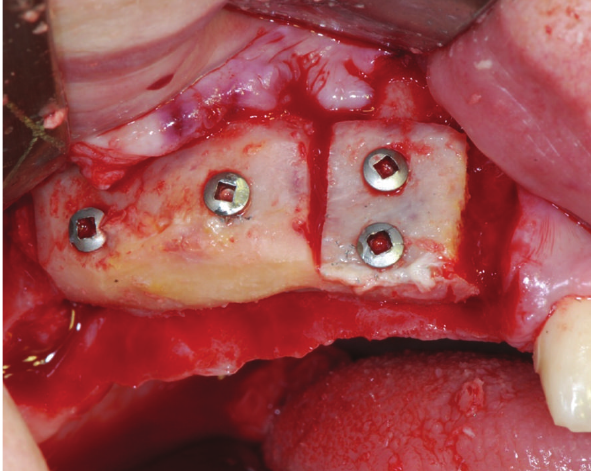
Figure 10: The patient is treated with sinus lift procedure and local ridge augmentation using fresh frozen bone.